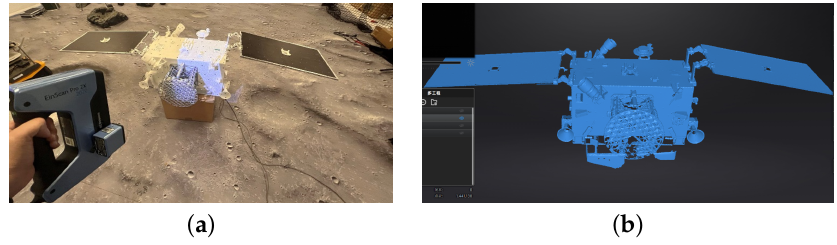
Figure 6. 3D scan system: ( a ) 3D scanner scan spacecraft. ( b ) 3D scan point